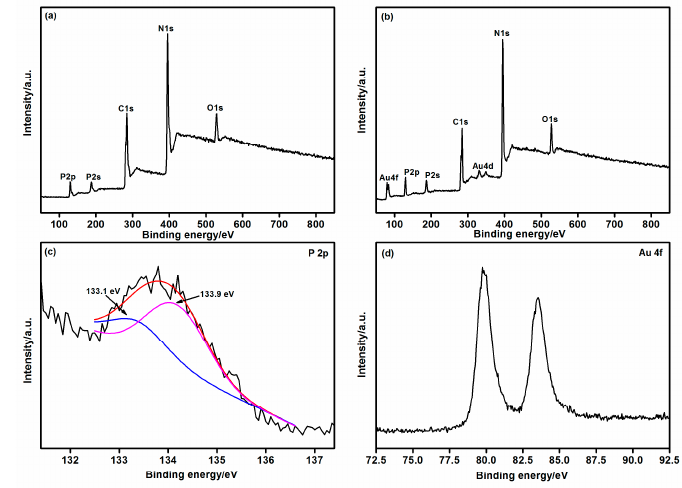
Figure 1. XRD spectrograms of g-C 3 N 4 , P-g-C 3 N 4 , 3% Au/g-C 3 N 4 and different Au/P-g-C 3 N 4 samples.